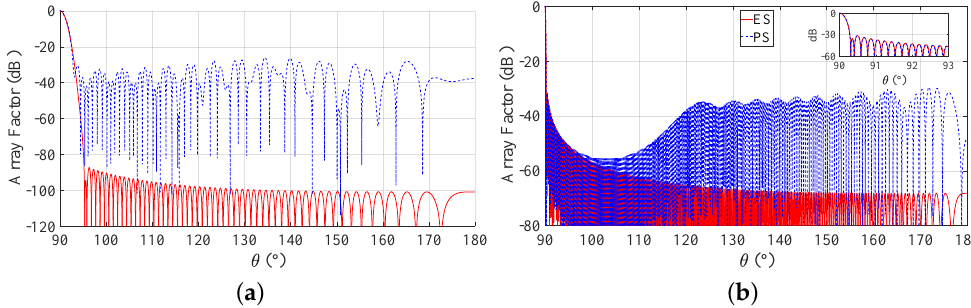
Figure 5. Obtained array factor with b = 3. Blue dashed lines refers to PS, and red solid lines refer to ES: ( a ) desired BW = 1 ◦ and L / λ = 60, ( b ) desired BW = 0.1 ◦ and L / λ = 300. The inset in the second subfigure reports a zoom of the main beam and of the first sidelobes.